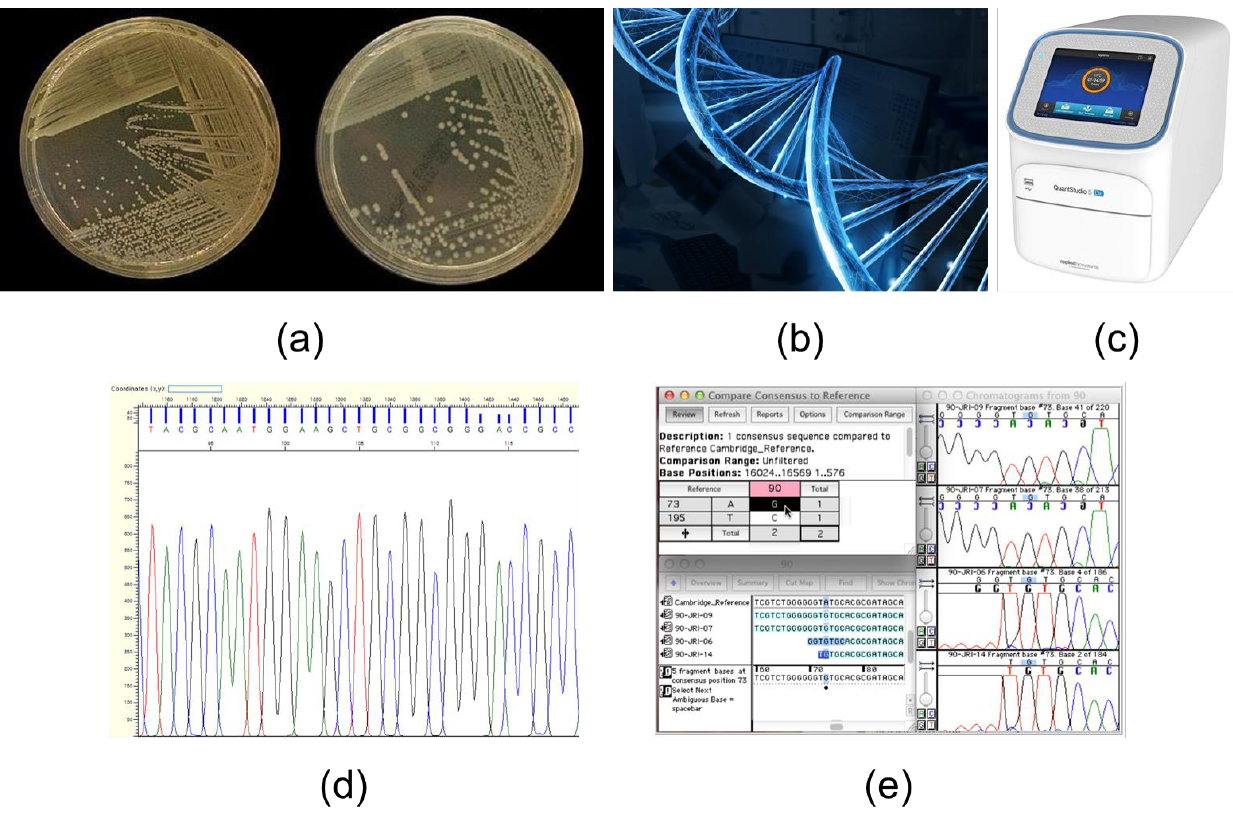
Figure 2. Procedure for the molecular analysis: ( a ) Isolation image performed in the preliminary experiment; ( b ) gDNA extraction concept image; ( c ) Image provided in the PCR equipment manual; ( d ) Sequencing analysis; ( e ) Images provided in the program manual.